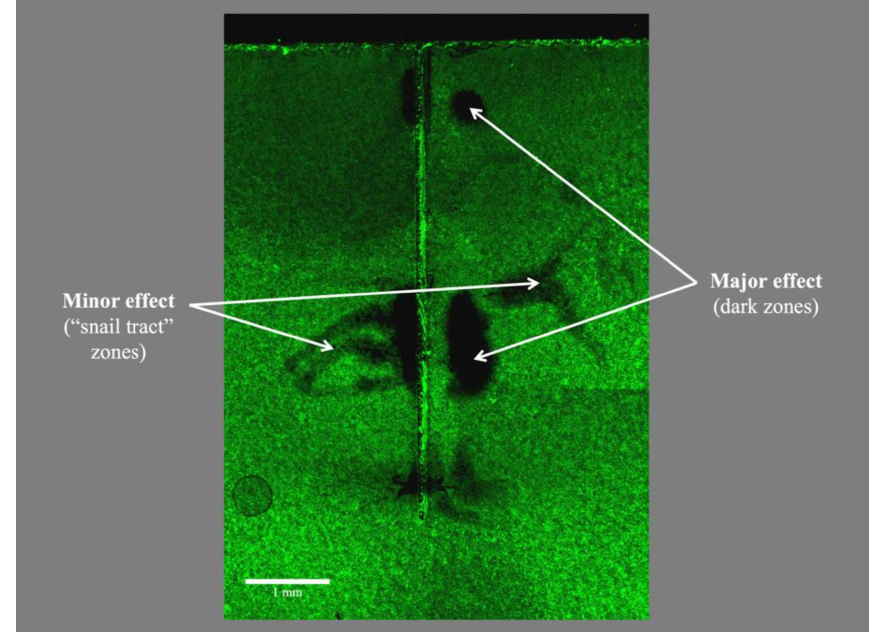
Figure 4. Typical appearance of the biofilm remaining on the polystyrene strip of the artificial canal model after passive ultrasonic irrigation, with viable bacteria stained and fluorescing in green. Notice (i) the absence of dead bacteria (that should have been stained in red), as sterile saline was used as the irrigant; (ii) non-uniform dislodgement of viable bacteria by the vibrating ultrasonic file which was held close to, but not in contact with that surface; and (iii) areas with dislodged bacteria were situated at a level approximating to the location of the anti-nodes of the vibrating